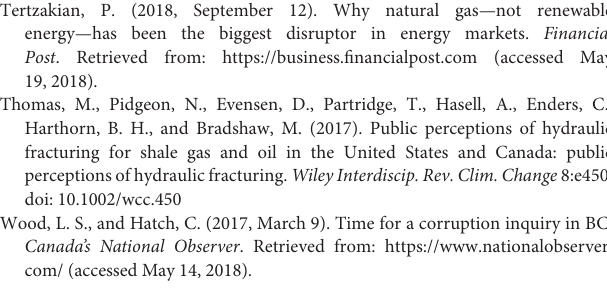
table. Nieman Lab . Retrieved from: https://www.niemanlab.org/2018/01/we- stepped-in-and-started-doing-ithow-one-woman-built-an-award-winning- news-outlet-from-her-dining-room-table/ (accessed May 14, 2018). Penner, D. (2015, July 2). Energy market shift adjusts LNG time frames . The Vancouver Sun , D1. Pett, D. (2009, July 4). Swimming in natural gas . The National Post , FP9. Pineault, É. (2016, May 18). Welcome to the age of extractivism and extreme oil. Canada’s National Observer . Retrieved from: https://www.nationalobserver. com (accessed May 14, 2018). Rankin, E., and McElroy, J. (2017, April 11). Fact check: promises, promises — lastelection’s’epicfail’. CBCNews .Retrievedfrom:http://www.cbc.ca(accessed May 18, 2018). Roy, G. (2018, January 25). Globe readership grows, most read in Canada. The Globe and Mail . Retrieved from: https://www.theglobeandmail.com (accessed May 19, 2018). Strömbäck,J.(2008).Fourphasesofmediatisation:ananalysisofthemediatisation of politics. J. Press Polit. 13, 228–246. doi: 10.1177/1940161208319097 Synder, J. E. (2016, October 1). Petronas assets may be a hard sell: analyst . The National Post , FP2. Tandt, M. D. (2016, September 30). Template for pipelines: approval for BC LNG shows Liberal strategy. The National Post, A5. Tasker, J. P. (2016, September 27). Federal government approves liquefied natural gas project on BC coast with 190 conditions. CBC News . Retrieved from: http:// www.cbc.ca (accessed May 18,